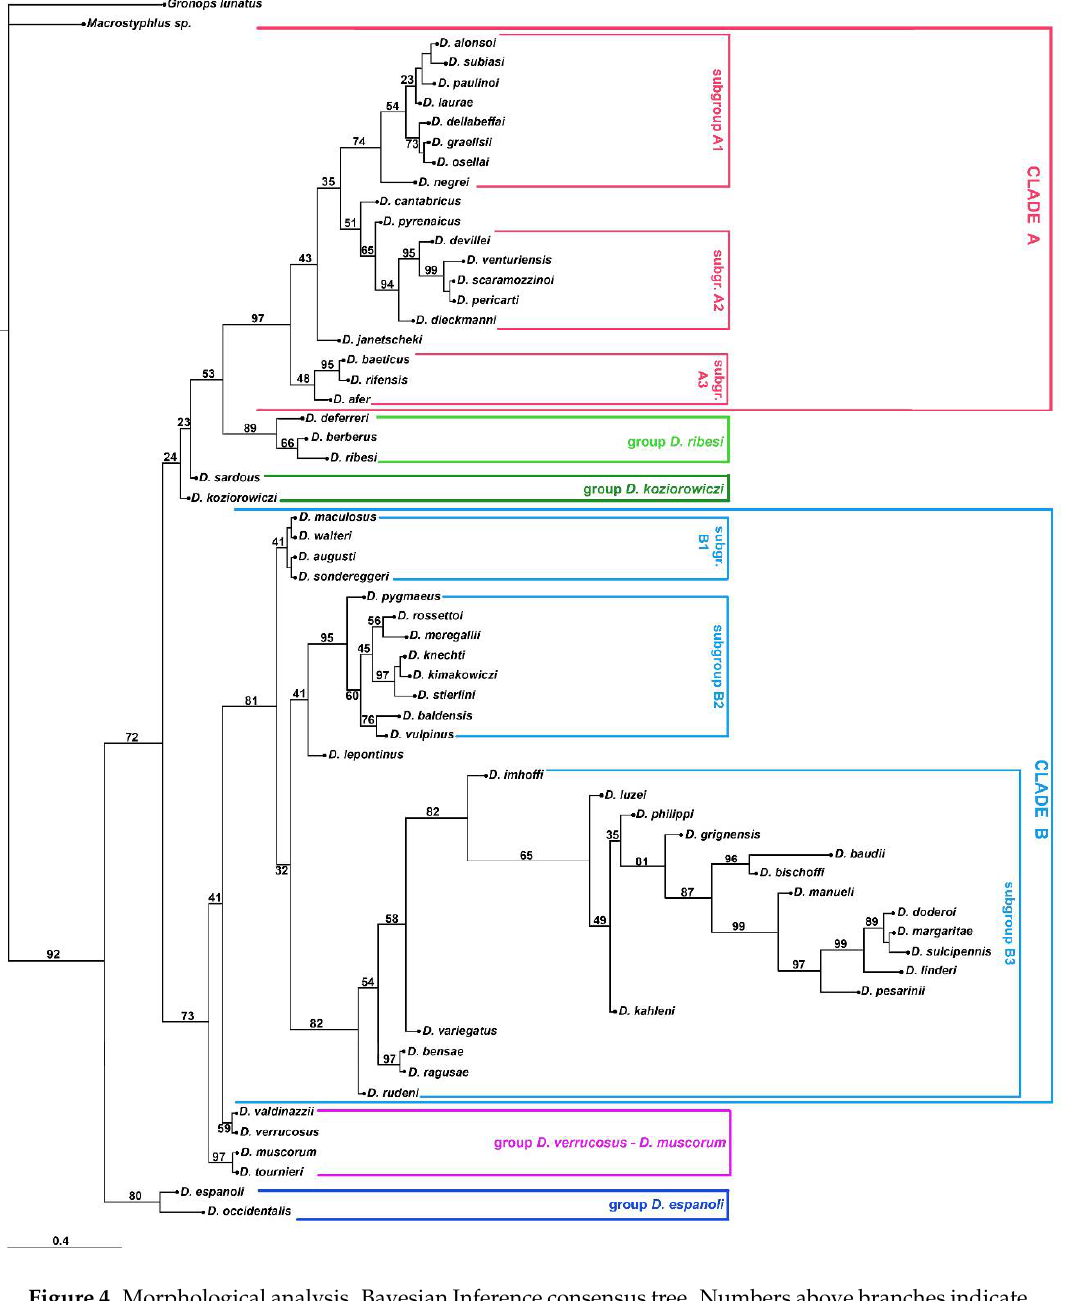
Figure 4. Morphological analysis. Bayesian Inference consensus tree. Numbers above branches indicate posterior probability. Scale bar unit: expected changes of state per character. See discussion for remarks on the clades and species group.